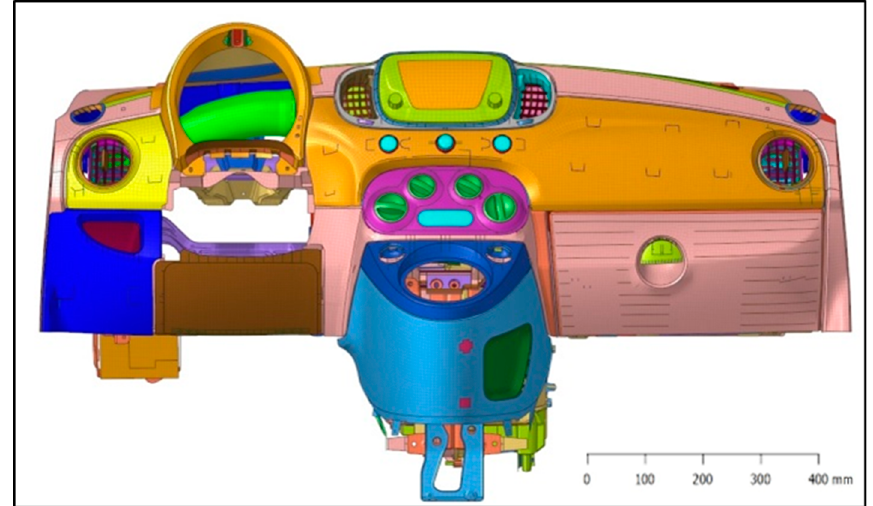
Figure 2. The FEM model considered in the analyses.